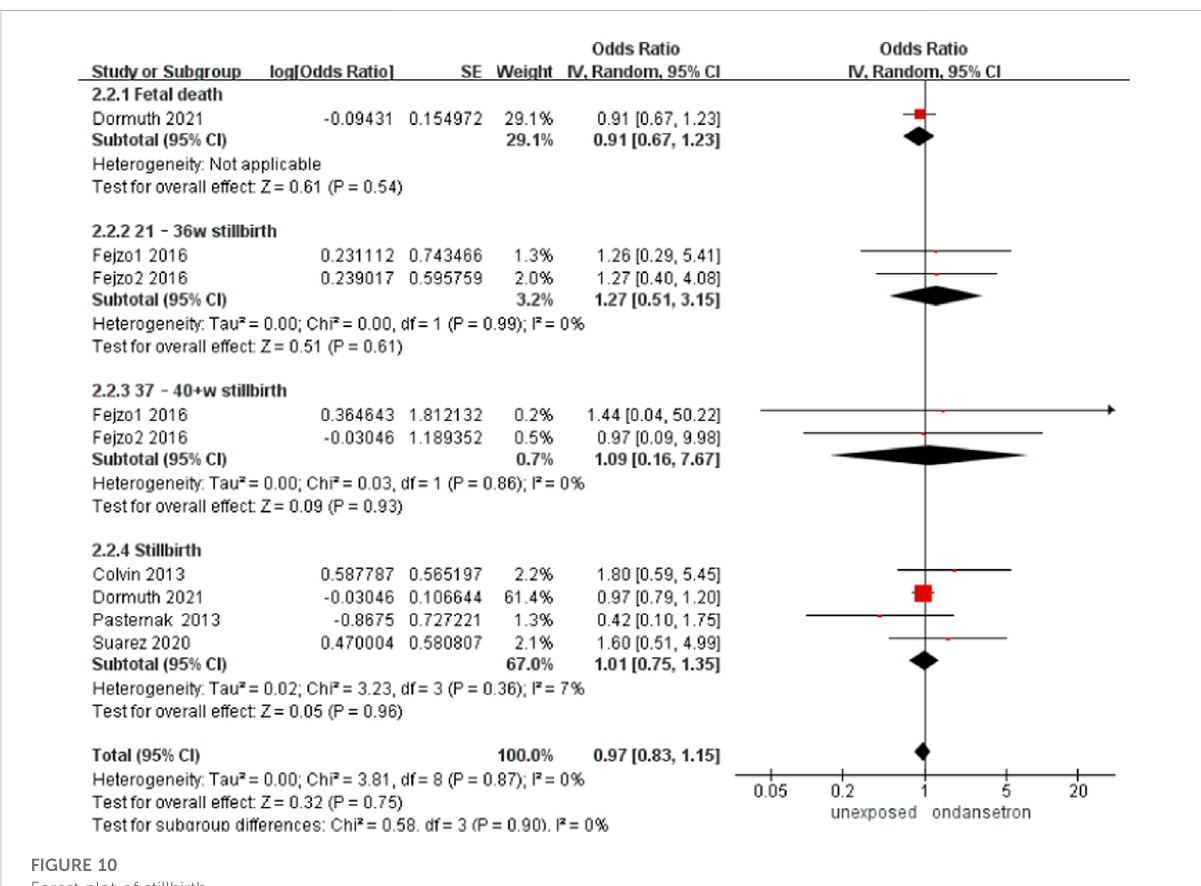
FIGURE 10 Forest plot of